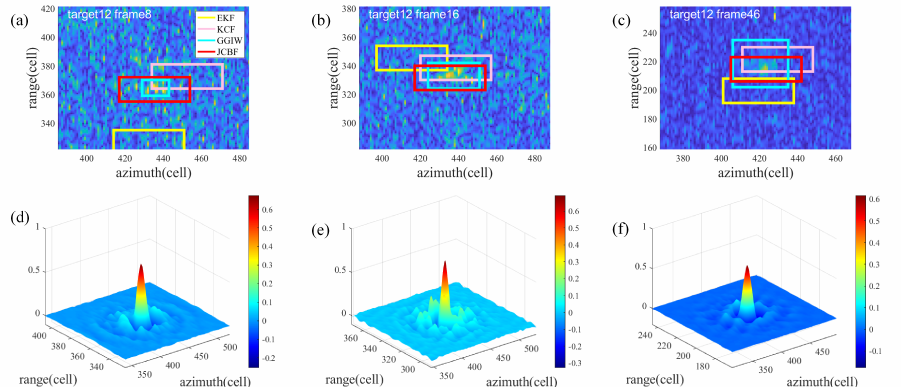
Figure 12. Tracking results of target 12 at some key frames. ( a – c ) The rusults of four trackers. ( d – f ) The responses of the proposed